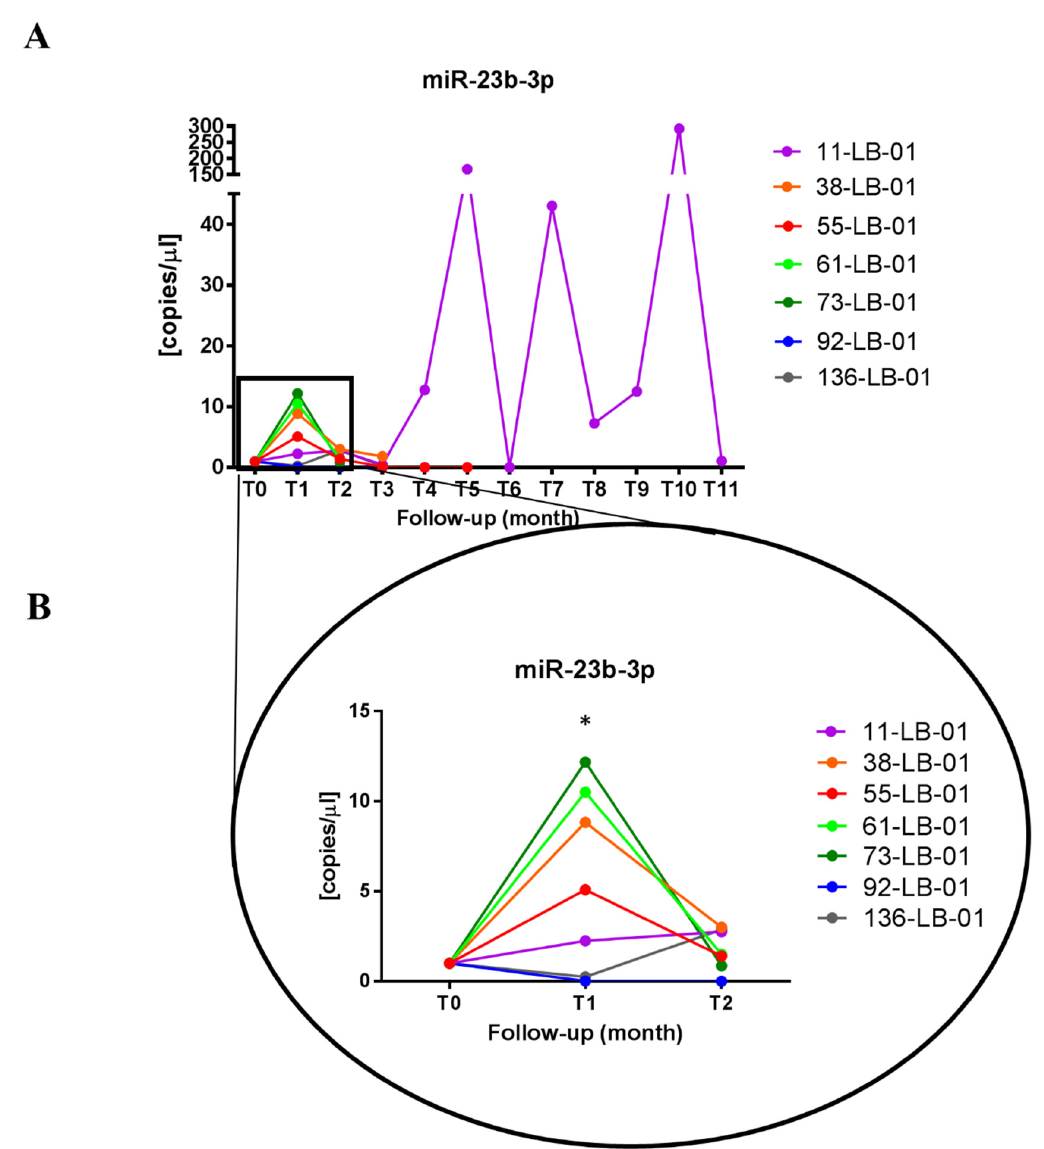
Figure 4. miR-23b-3p levels in the plasma of HCC patients treated with sorafenib. ( A ) The graph shows the amount of miR-23b-3p detected in the plasma of each HCC patient during sorafenib treatment. Each line represents one patient, and the dots indicate the levels of miR-23b-3p at each blood withdrawal time point (one per month, Tn) normalized on the miR-23b-3p level before the start of treatment (T0). ( B ) Focus on miR-23b-3p early levels after sorafenib administration. T n indicates the sequential blood withdrawal point carried out once per month. One-way ANOVA, followed by Tukey’s test, was used to compare miR-23b-3p levels among three time points (T0, T1, and T2), * indicates a p -value < 0.05 versus T0.